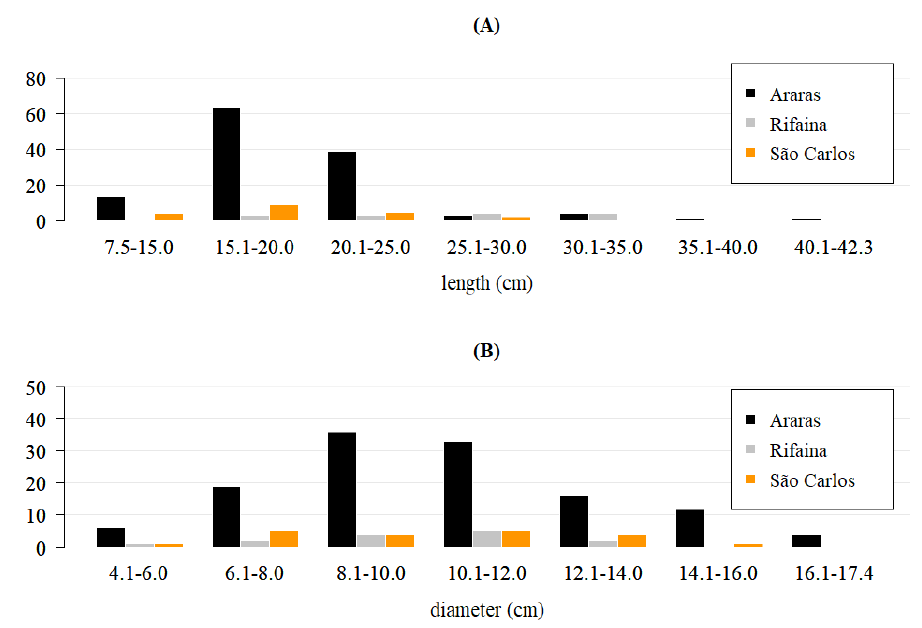
Fig 4 . Lenght (A) and diameter (B) of the trap-nests used by the females of P . denticulatum in the three sampled areas.